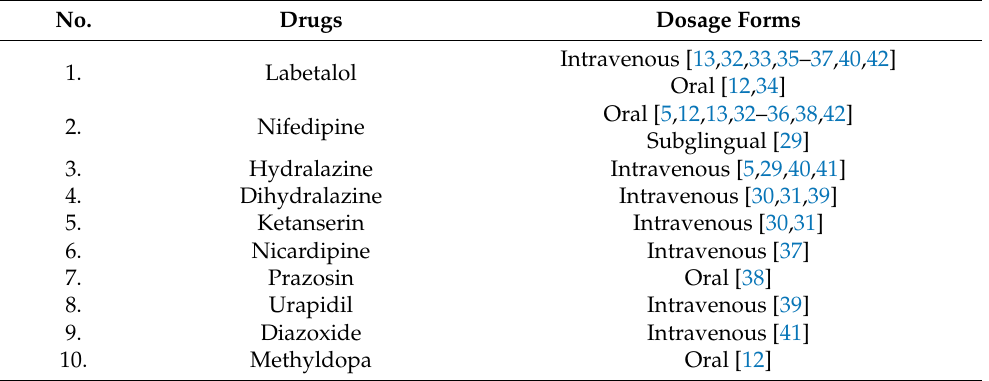
Table 2. Dosage forms of drugs